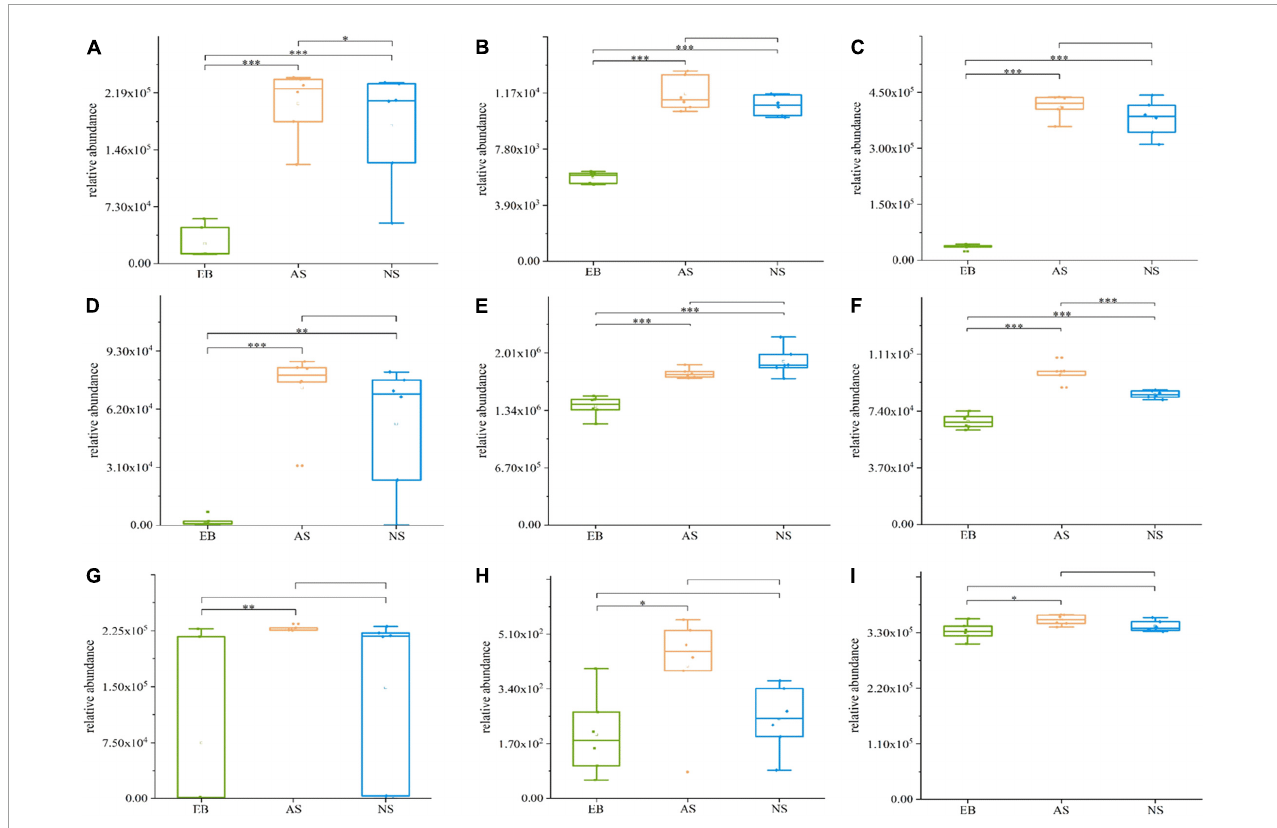
FIGURE8 Boxplots of partially differential metabolites enriched in ABC transporters and biosynthesis of amino acid pathways in Polygonati Rhizoma fermented by Lactiplantibacillus plantarum under aerobic and anaerobic conditions. (A) L-arginine; (B) L-aspartic acid; (C) leucine; (D) L-lysine; (E) citrate; (F) inosine; (G) carnitine; (H) betaine; and (I) thiamine. AS, aerobic fermentation supernatants; NS, anaerobic fermentation supernatants; EB, Polygonati Rhizoma extractives before fermentation. * p < 0.05, ** p < 0.01, and *** p < 0.001.